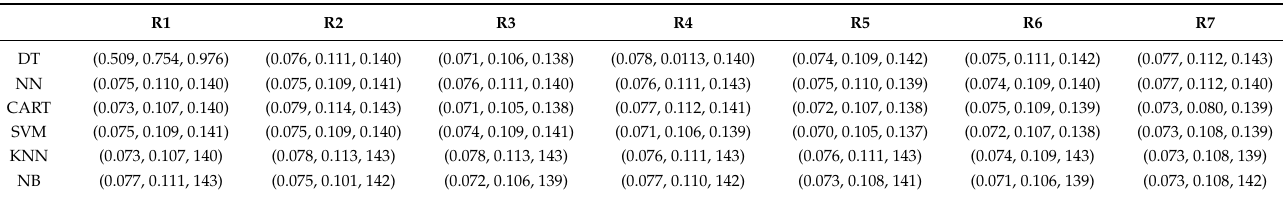
Table 6. The weighted standardized judgment